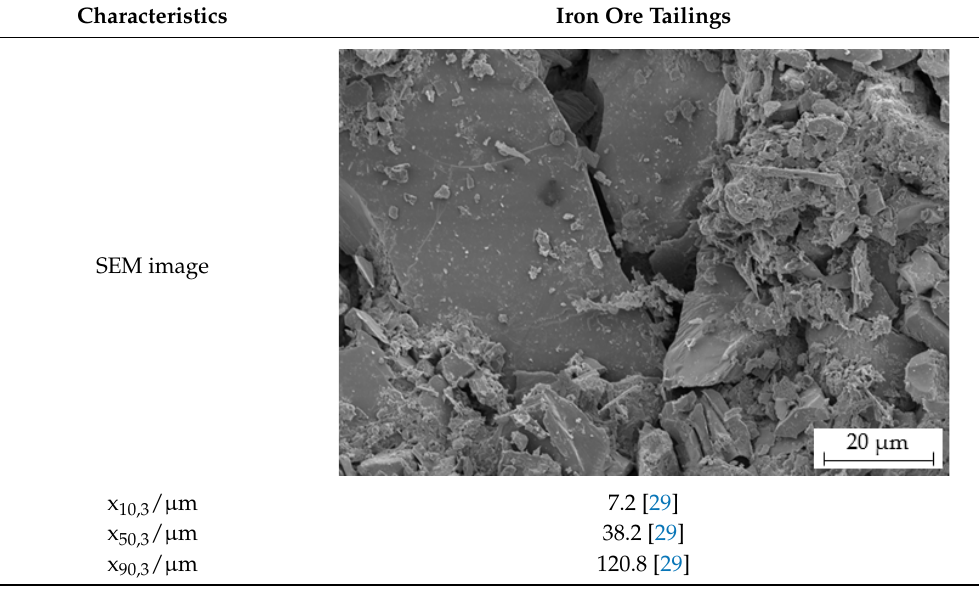
Table 1. SEM image (1000 × ) and characteristic PSD excerpts of the iron ore tailings. Characteristics